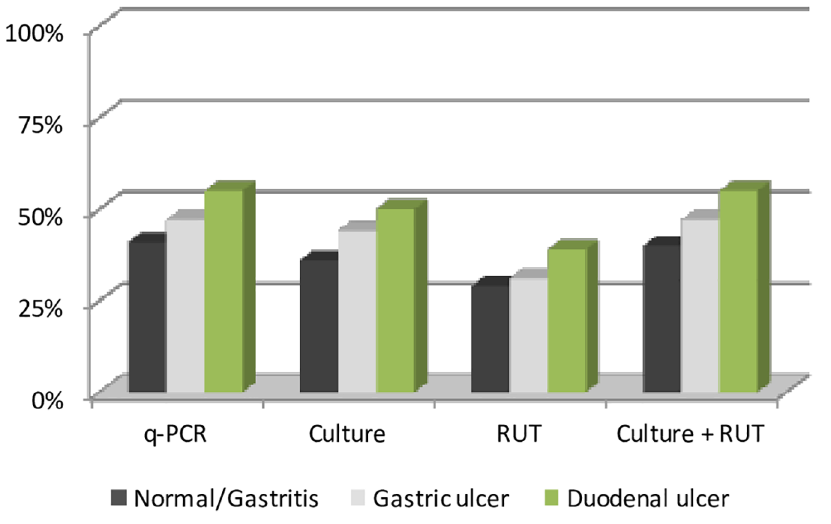
Fig 2. Percentage of biopsies testing positive for H . pylori